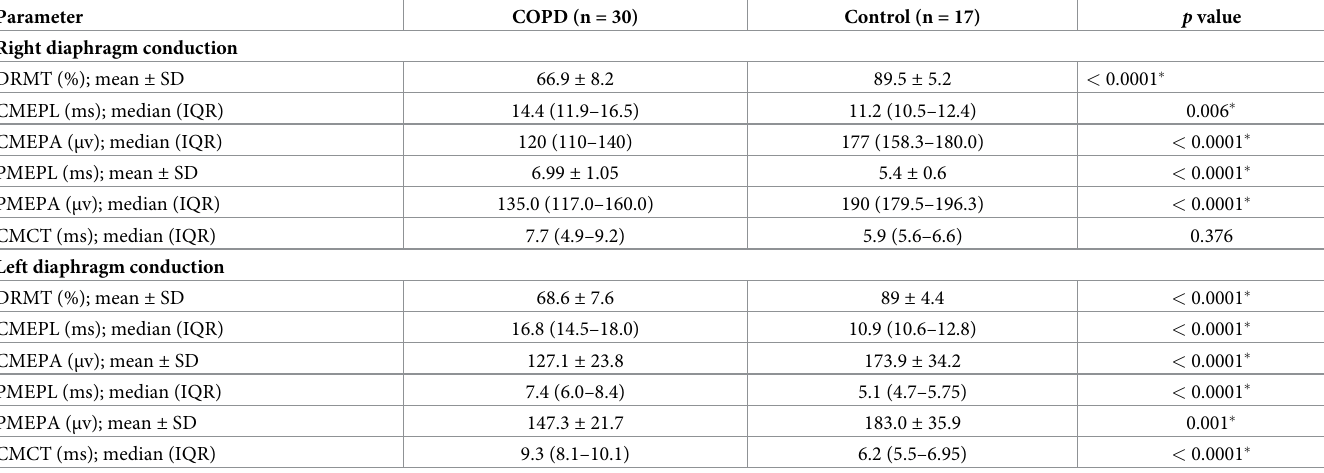
Table 2. Comparison between the two studied groups regarding diaphragmatic CMEP and PMEP parameters.